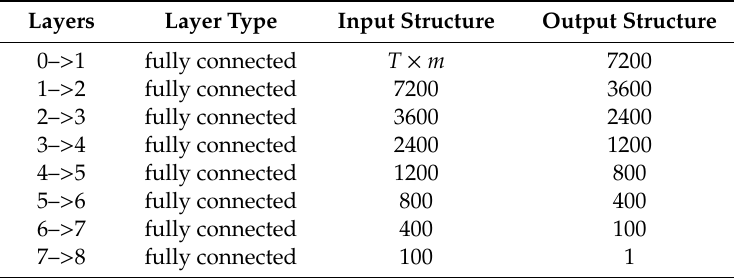
Table 2. The architecture of MLP with hourly input data.